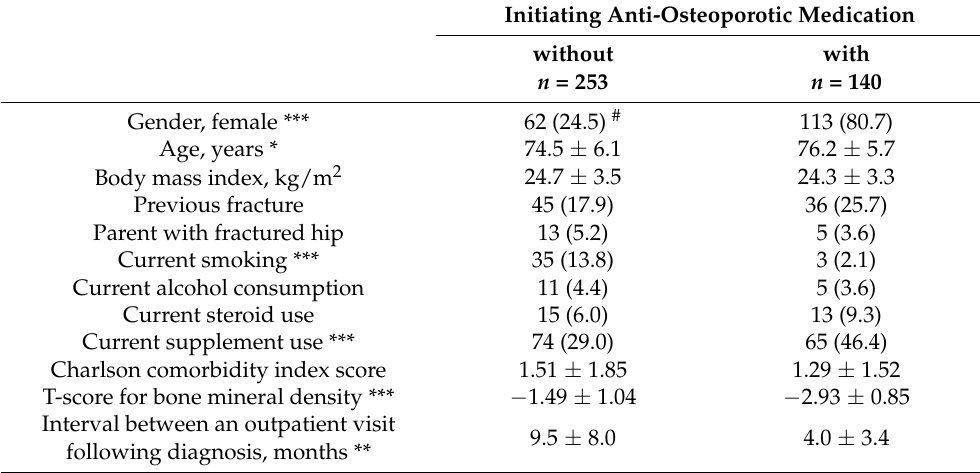
Table 3. Demographic characteristics of 393 subjects with or without initiating anti-osteoporotic medication within 2 years after diagnosis.